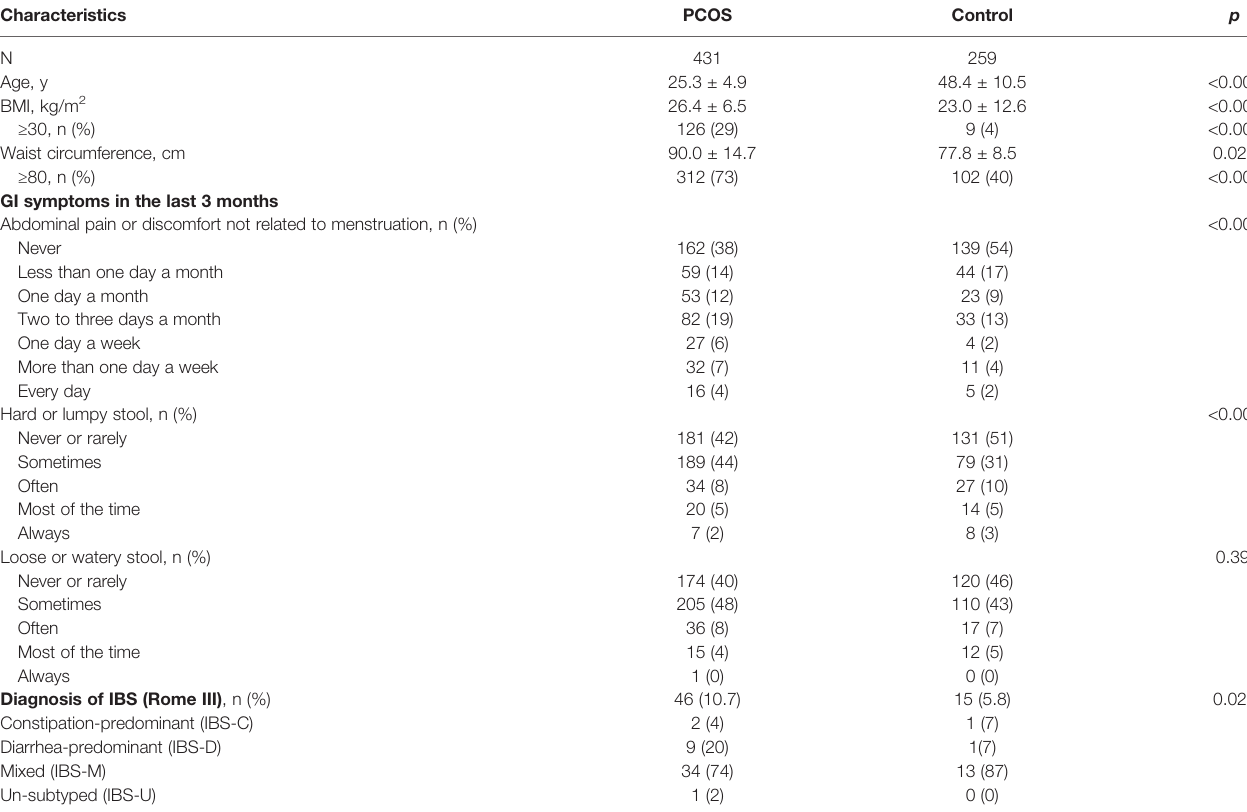
TABLE 1 | Demographic characteristics, anthropometrics, bowel symptom pro fi les, and prevalence of irritable bowel syndrome in PCOS and control groups.